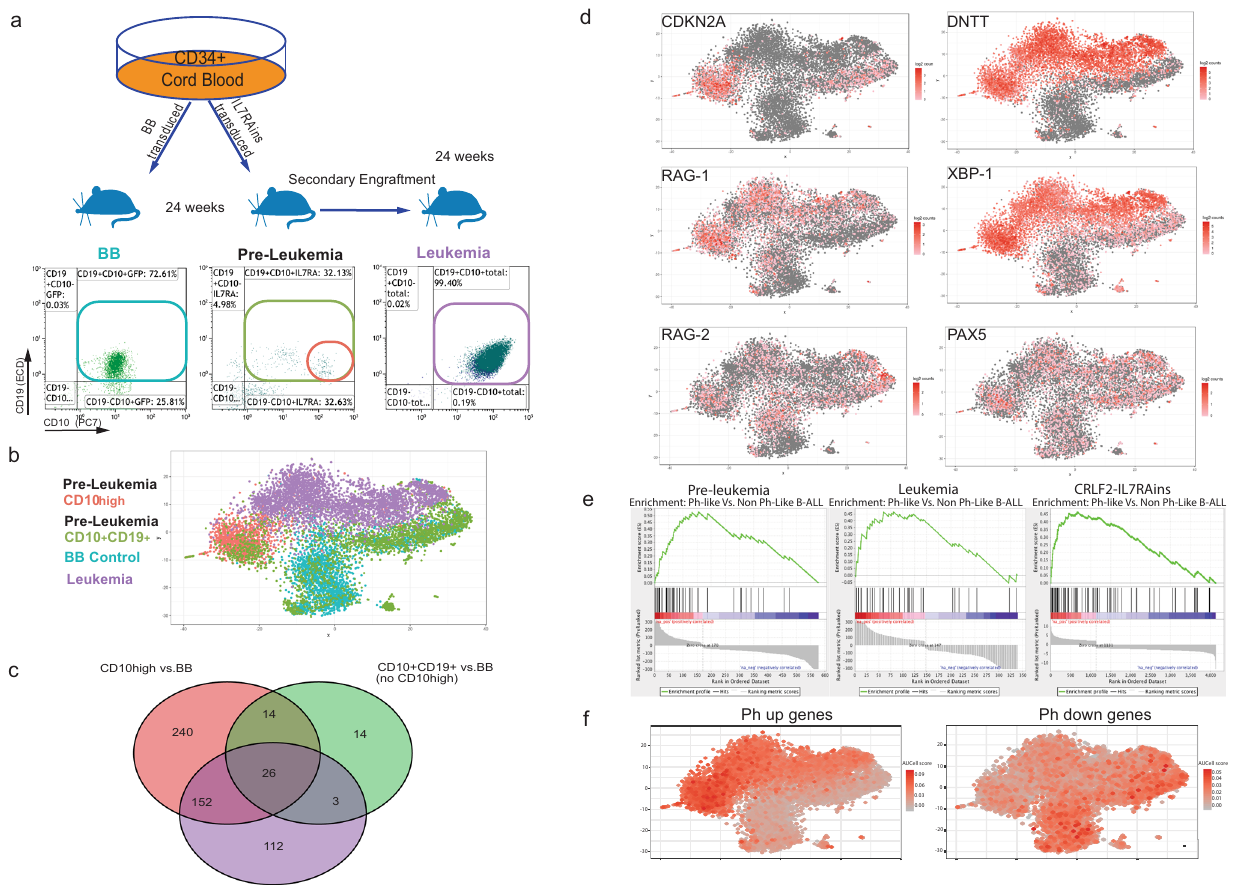
Fig. 4 Philadelphia-like ALL gene signature in bulk and scRNAseq analyses of activated IL7RA-engrafted cells. a Scheme of sample acquisition for scRNAseq. b Transcriptome correlation t-SNE map after 10X scRNAseq. c Venn diagram of differentially expressed genes in bulk analysis of CD10 + CD19 + and CD19 + CD10 high cells of the preleukemic mouse and leukemia sample vs BB control sample Source data are provided as a Source Data fi le. d Relative expression of selected genes displayed on t-SNE map. e GSEA enrichment plot of preleukemic cells, leukemic cells and CRLF2-IL7RAins over BB differentially expressed genes aligned to Ph-like vs non Ph-like ranked gene list ( f ) AUCell analysis for single-cell expression of Ph-like (Ph) gene set projected on t-SNE